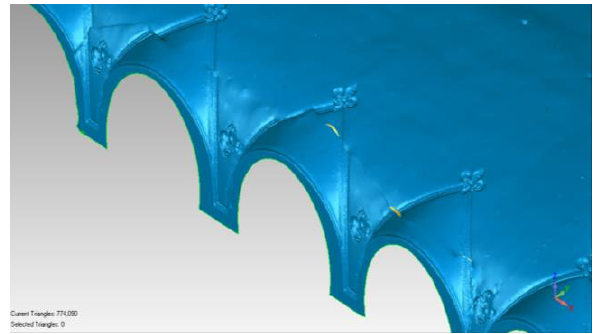
Figure 6. The voids (or “shadows”) in the laser scanner